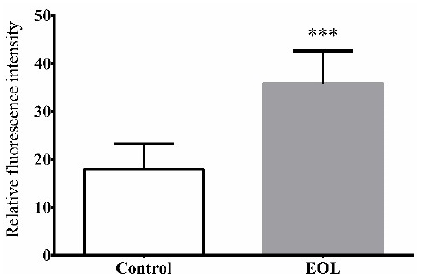
Figure 5. The effect of EOL on reducing ROS in C. elegans . Differences were considered to be significant at p < 0.05 (*).